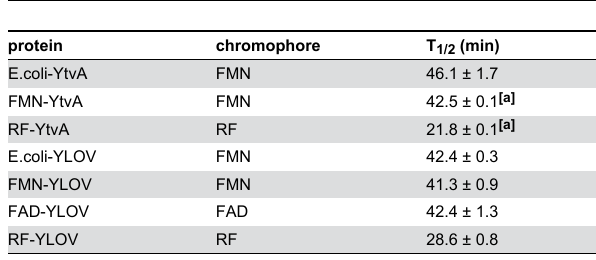
Table 3. Lit state half lives of flavin-reconstituted YtvA and YLOV.